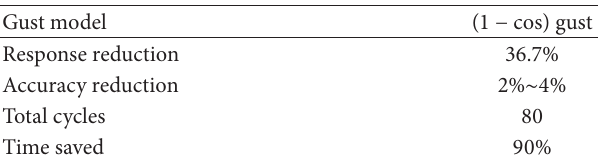
Table 4: Prediction method’s performance in trimmed free-flight